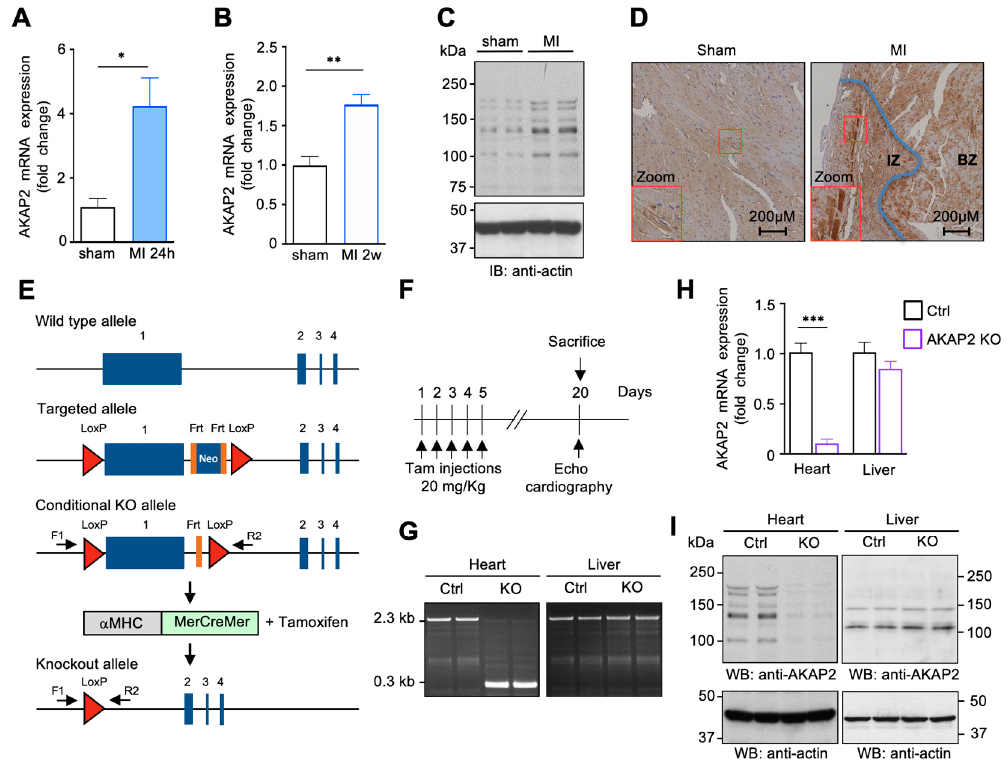
Figure 1. Cardiac AKAP2 is upregulated after myocardial infarction. ( A , B ) Quantitative real-time PCR analysis of cardiac AKAP2 mRNA expression in C57BL/6 mouse hearts subjected to sham operation or LAD ligation for 24 h (MI 24 h) (A) or 2 weeks (MI 2w) ( B ). Sham n = 4, MI 24 h n = 4, MI 2w n = 4. ( C ) Immunoblot analysis of AKAP2 expression in lysates from mouse hearts subjected to sham operation or LAD ligation (MI) for 2 weeks. ( D ) Anti-AKAP2 stainings of transversal heart sections from mice undergoing sham operation or LAD ligation (MI) for 2 weeks. The boundary between infarcted (IZ) and border zone (BZ) is indicated by a blue line. ( E ) Schematic representation of the AKAP2 genetic locus and the strategy used to create cardiomyocyte-specific AKAP2 knockout mice. AKAP2 exon1 is deleted following administration of tamoxifen to AKAP2 fl/fl ; α -MHC-MerCreMer mice. PCR primers F1 and R2 were used to assess homologous DNA recombination in cardiac tissues. ( F ) Experimental scheme for inducing AKAP2 gene deletion. ( G ) Assessing homologous DNA recombination in AKAP2 fl/fl ; α -MHC-MerCreMer mice. Primers F1 and R2 amplify a 2.4 kb fragment in untreated (Ctrl) mice and a 0.28 kb product following tamoxifen-induced Cre-mediated exon 1 deletion (KO). ( H ) AKAP2 mRNA expression in heart and liver lysates from control (Ctrl) and AKAP2 KO mice was assessed by quantitative real-time PCR. Ctrl n = 4, AKAP2 KO n = 4. ( I ) AKAP2 immunoblots of heart and liver lysates from control (Ctrl) and AKAP2 KO mice. Values are presented as mean ± SEM; * p < 0.05, ** p < 0.01 and *** p <